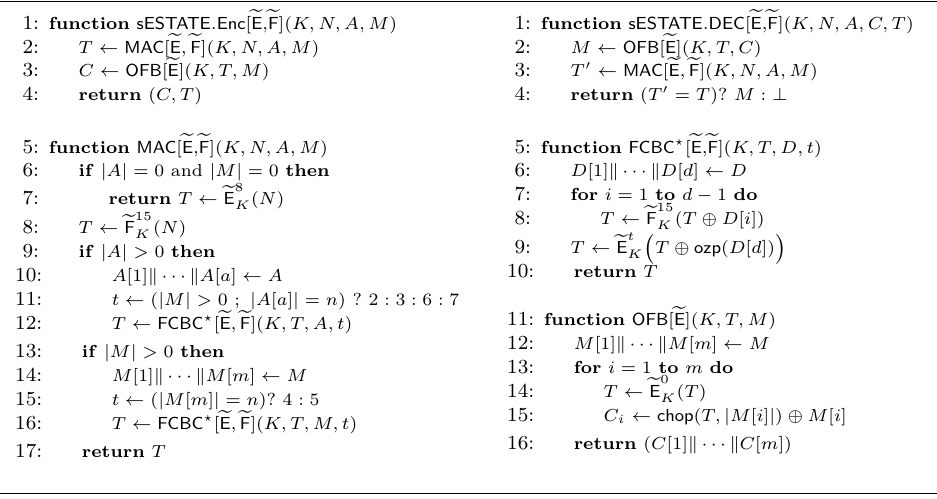
Algorithm 2 sESTATE Authenticated Encryption and Verified Decryption Algorithm. Here e F is a round-reduced variant of e